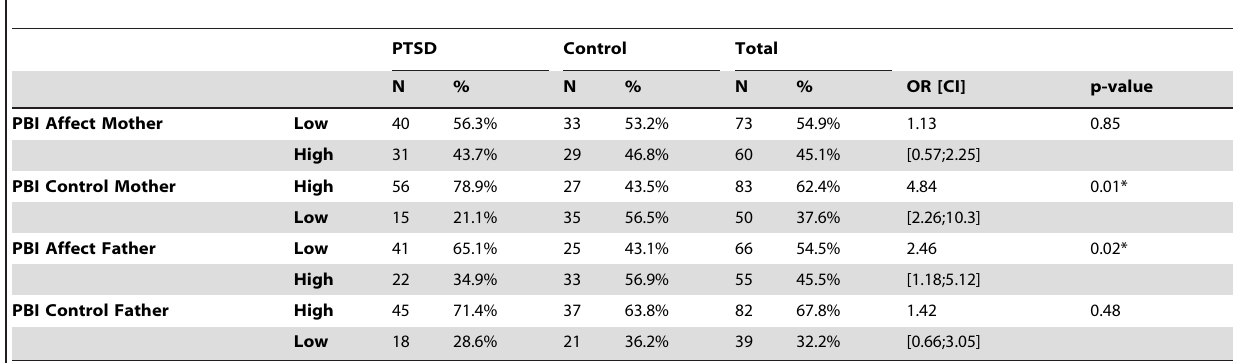
Table 2. Distribution of PBI care and control scores for the mothers and fathers of patients with PTSD and controls.